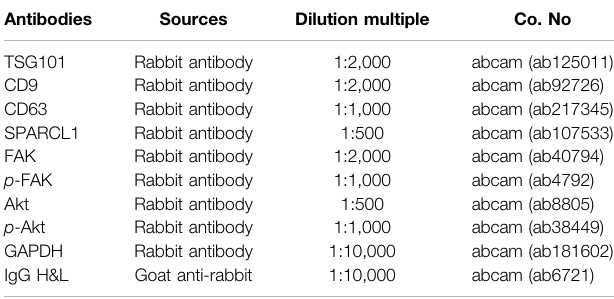
TABLE 2 | Antibodies for Western blot. Antibodies